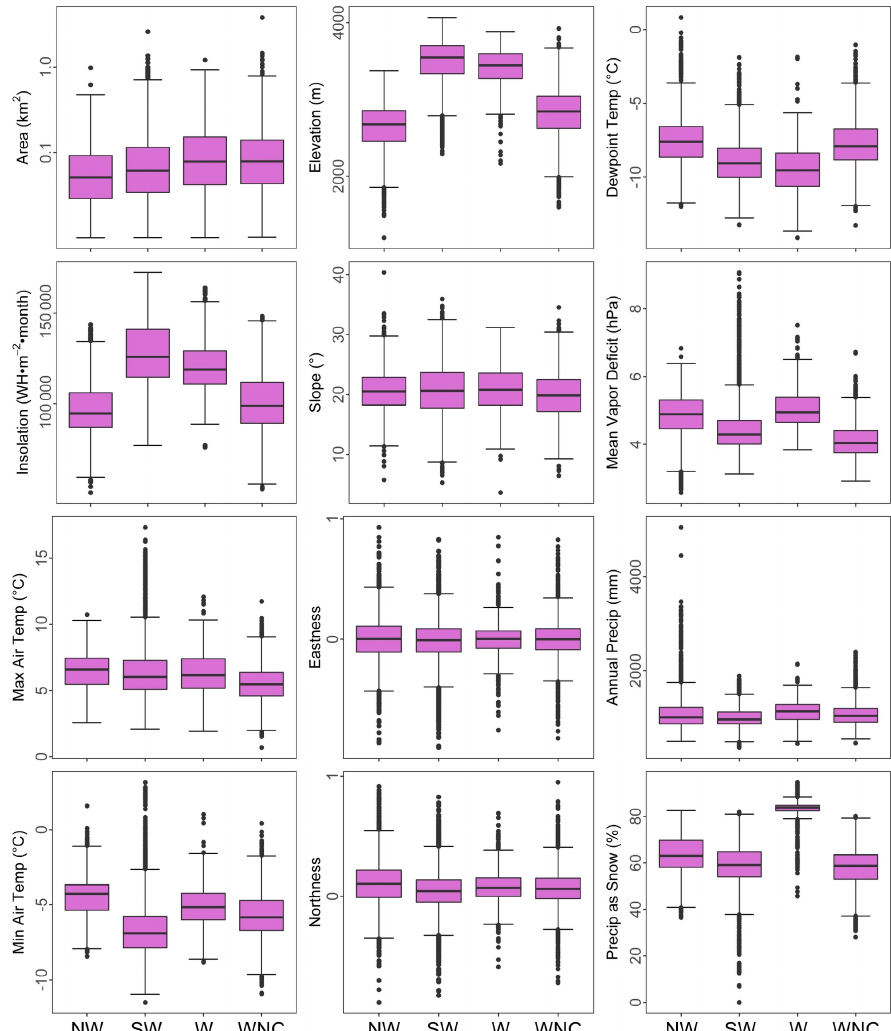
Figure 5. Geographic characteristics of rock glaciers by NOAA climate region. Boxplot whiskers represent 1.5 times the interquartile range, and outliers beyond those values are shown by solid